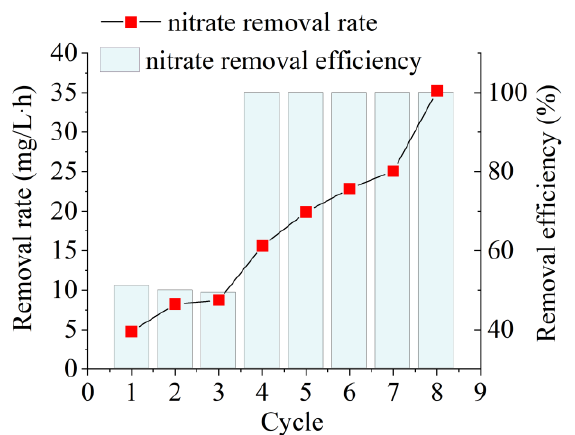
Figure 2. Nitrate removal performance of aerobic denitrification (AD) flora during enrichment of raw activated sludge obtained from a traditional water treatment processing plant.